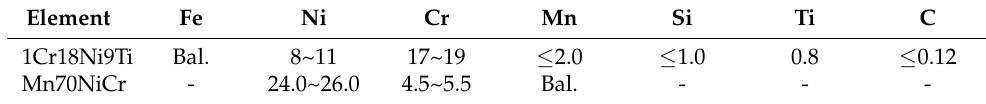
Table 1. Chemical composition of the base substrate and brazing alloy (wt.%). Element